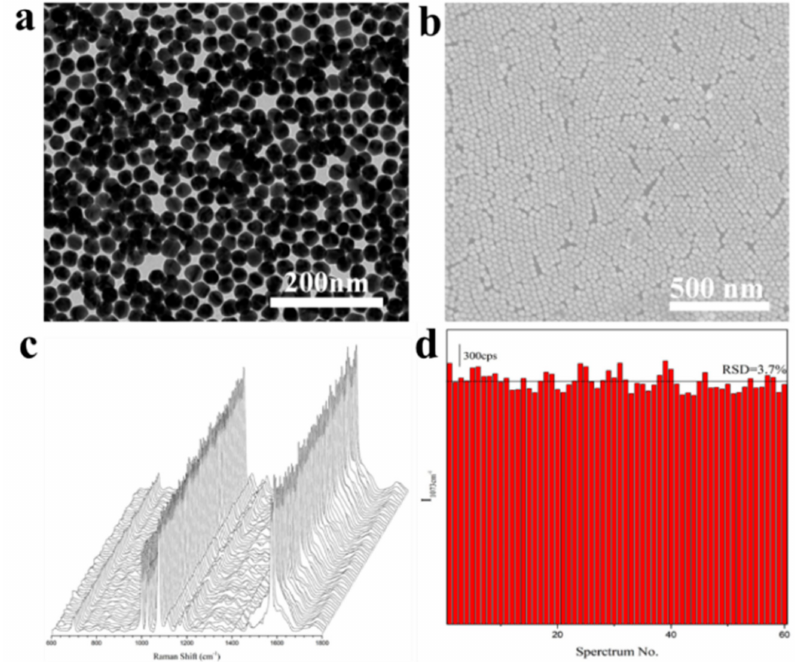
Figure A2. TEM and SEM images of 30 nm Au nanoparticle MLF ( a , b ); SERS of thiophenol on the Au nanoparticle MLF ( c ) and the intensities of SERS bands at 1073 cm − 1 ( d ) on 60 points.